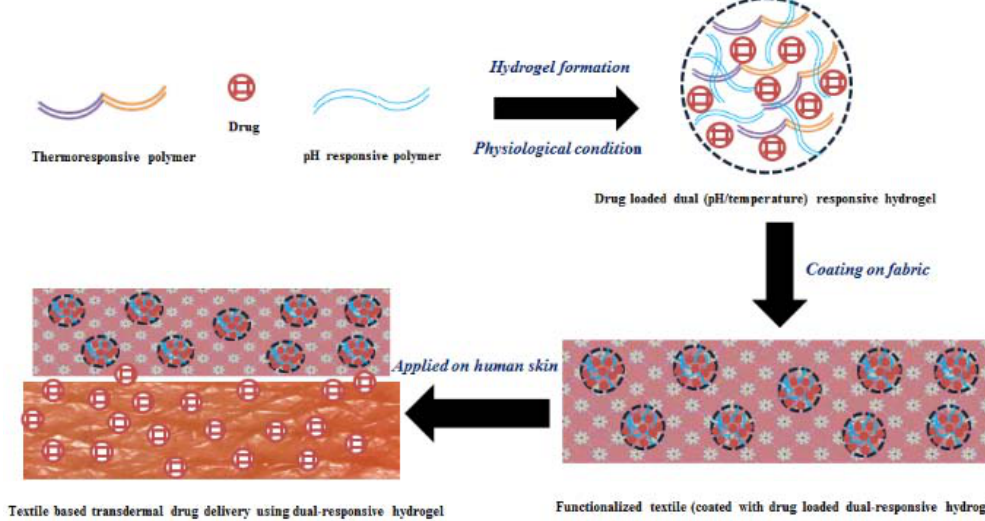
Figure 3. Textile based transdermal drug delivery using dual (pH/temperature) responsive hydrogel.